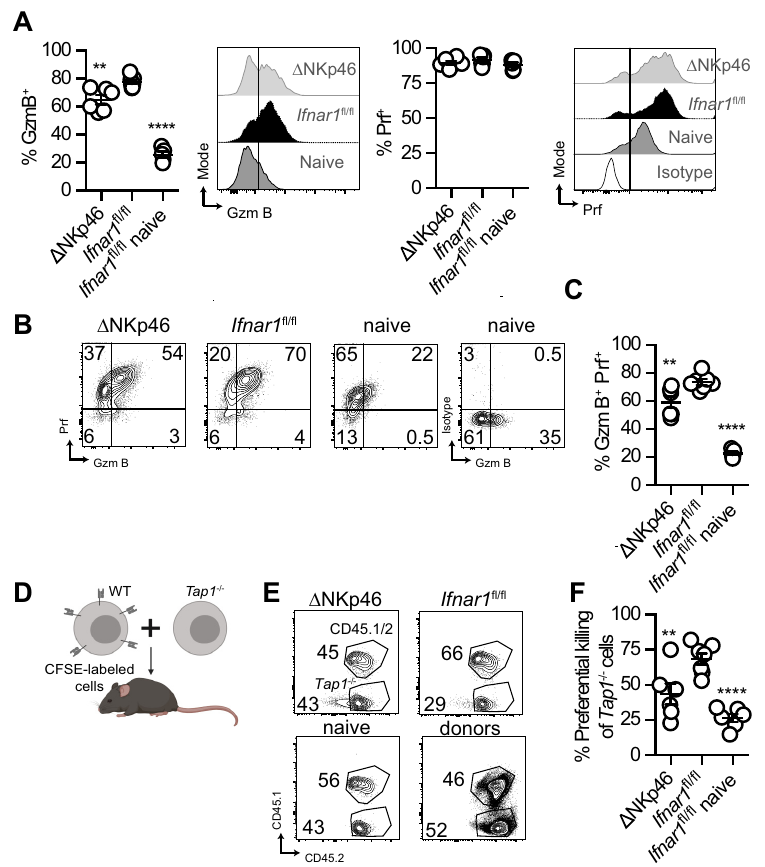
Fig 5. NK cells require IFNAR for optimal maturation, activation, and cytolytic killing. (A) Graphs and concatenated flow cytometry histograms depicting GzmB and Prf expression in gated NK cells (NK1.1 + TCR β - ) from spleens of the indicated na ï ve or infected mice at six dpi. (B-C) Concatenated flow cytometry plots (B) and frequency (C) of GzmB + Prf + NK cells (NK1.1 + TCR β - ) in spleens of the indicated mice at 6 dpi. (D) Mice were infected with 3000 pfu of WT ECTV in the footpad and CFSE-labeled WT + Tap1 -/- splenocytes at a 1:1 ratio were transferred i.v. Two hours before organ harvest at 6 dpi. Created with BioRender.com. (E-F) Concatenated flow cytometry plots (E) and proportions (F) of the preferential killing of Tap1 -/- cells (CFSE high CD45.2) over WT cells (CFSE high B6.CD45.1) normalized to donor transfer ratio in spleens of the indicated na ï ve and infected mice at 6 dpi. Data are represented as mean ± SEM from two pooled independent experiments (N = 6 or 7 for each group, ANOVA with Tukey correction compared to Ifnar1 fl/fl infected mice).